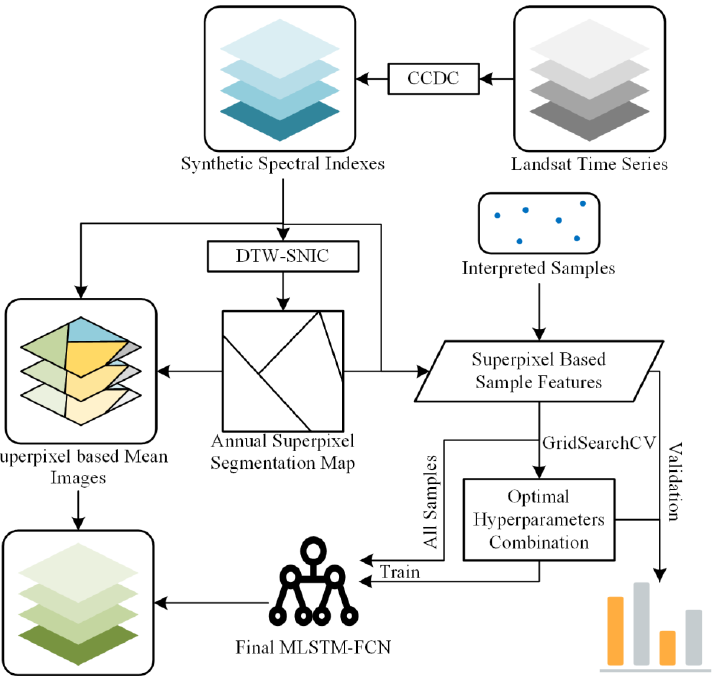
Figure 3. Flowchart of paddy rice mapping in this study. CCDC: Continuous Change Detection and Classification. DTW-SNIC: Dynamic-Time-Warping-based Simple Non-Iterative Clustering. MLSTM-FCN: Multivariate Long Short-Term Memory Full Convolution Neural Network. MLSTM-FCN: Multivariate Long Short-Term Memory Full Convolution Neural